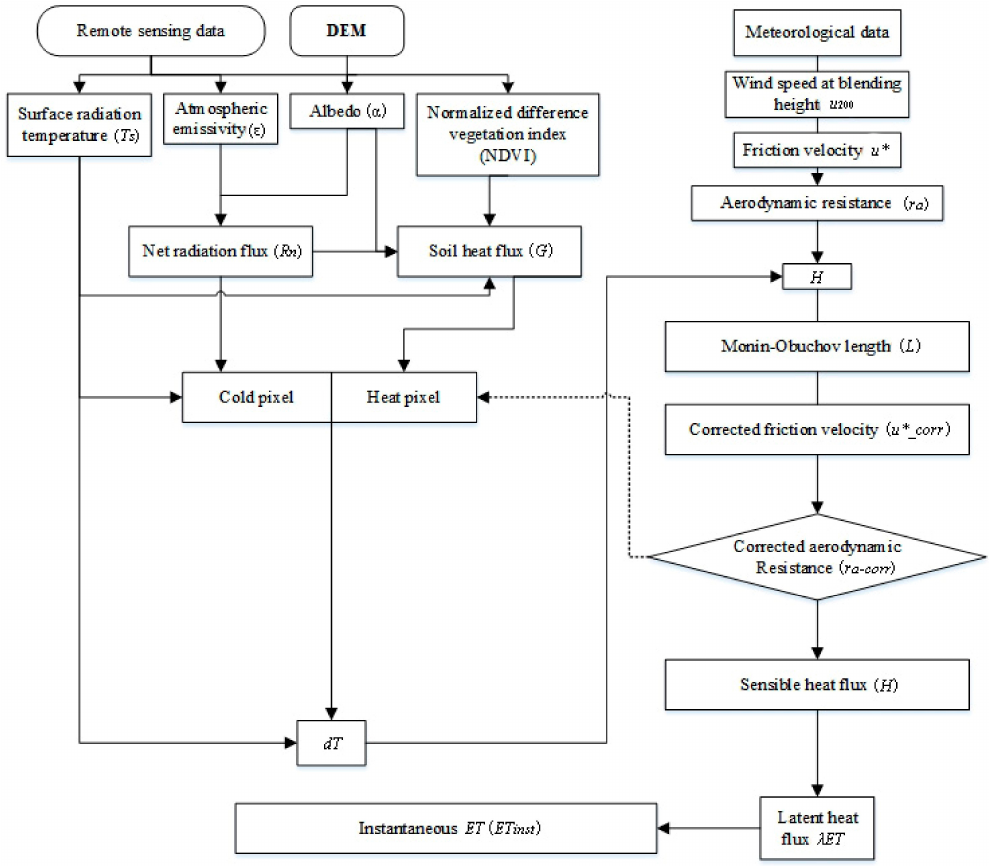
Figure 4. The algorithm flow of the Surface Energy Balance Algorithm